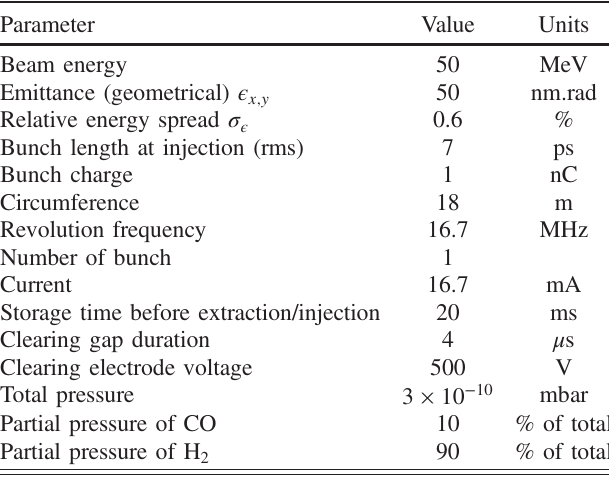
TABLE I. ThomX storage ring design